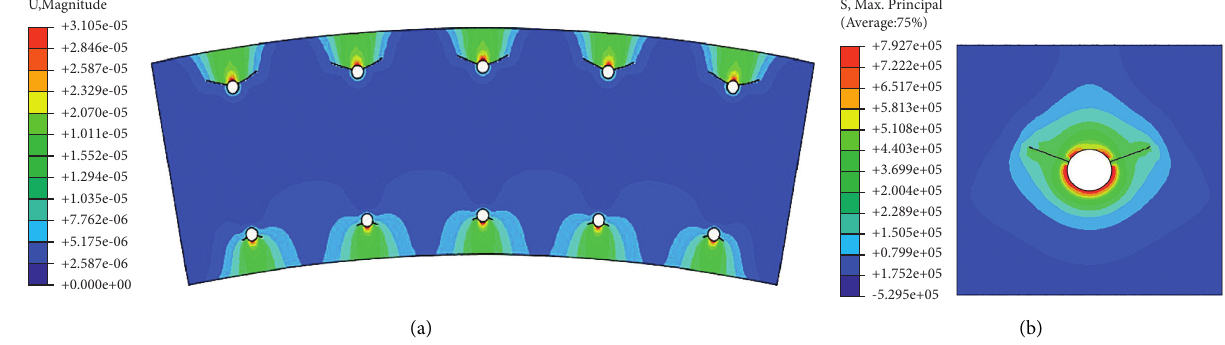
Figure 13: Degradation characteristics of the segment after 1 year of steel bar corrosion: (a) the displacement cloud during cracking and (b) the maximum principal stress cloud during cracking.